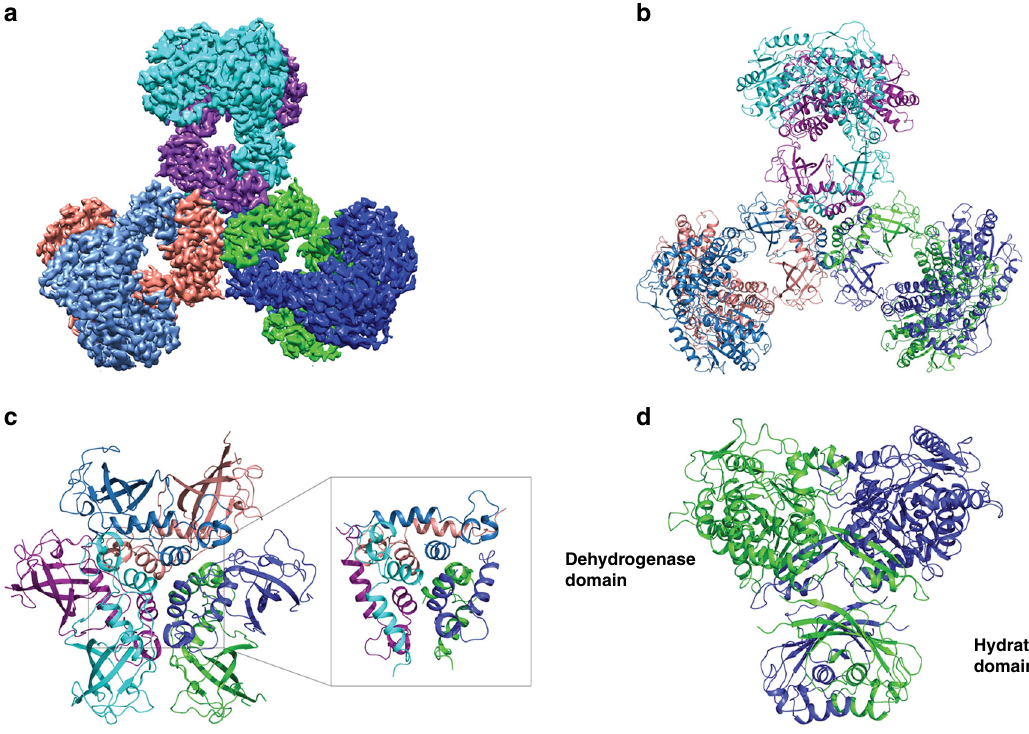
Fig. 2 Architecture of PaaZ. a CryoEM map of substrate-free PaaZ revealing a trilobed architecture. The density corresponding to each monomer is colored individually, clearly showing the domain swap in each module. b The model derived from the cryoEM map with each polypeptide colored as in panel a . The fi nal model consists of residues 2 – 679 with only the loop regions de fi ned poorly. c Six monomers of the hydratase domain form the central inner core. Short helices from each monomer form two layers with an additional helix that lies perpendicular and wraps around to form a tight knit core (inset). d Two polypeptides of PaaZ (green and blue) form a module with the domain of the C-terminal hydratase, which is swapped between